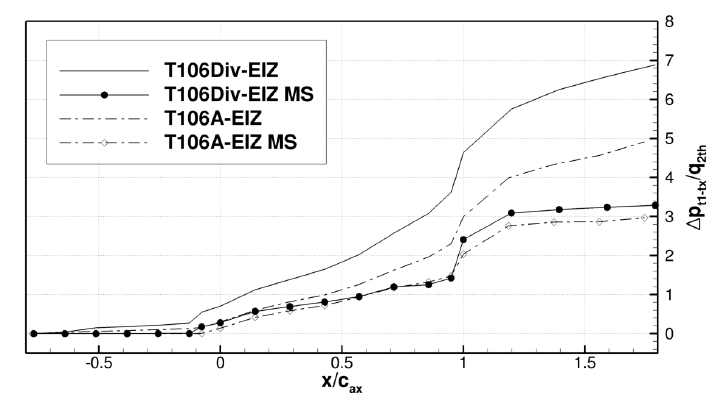
Figure 5. Comparison of mid-span (MS) and overall losses for the T106A-EIZ and